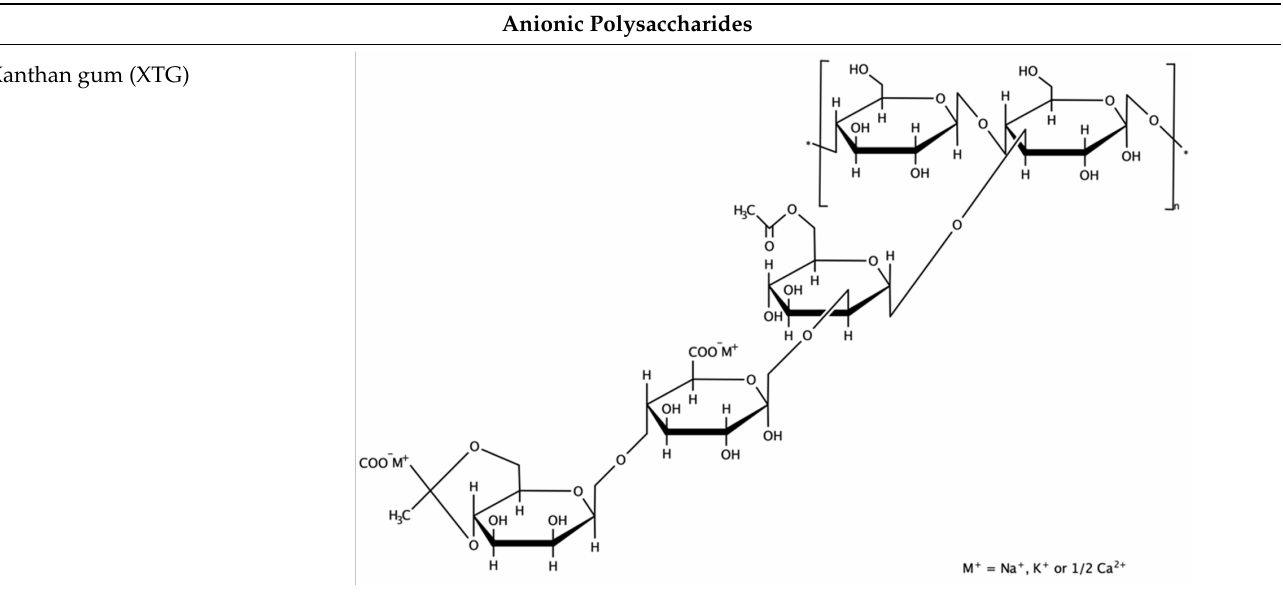
Table A1. The building units of selected